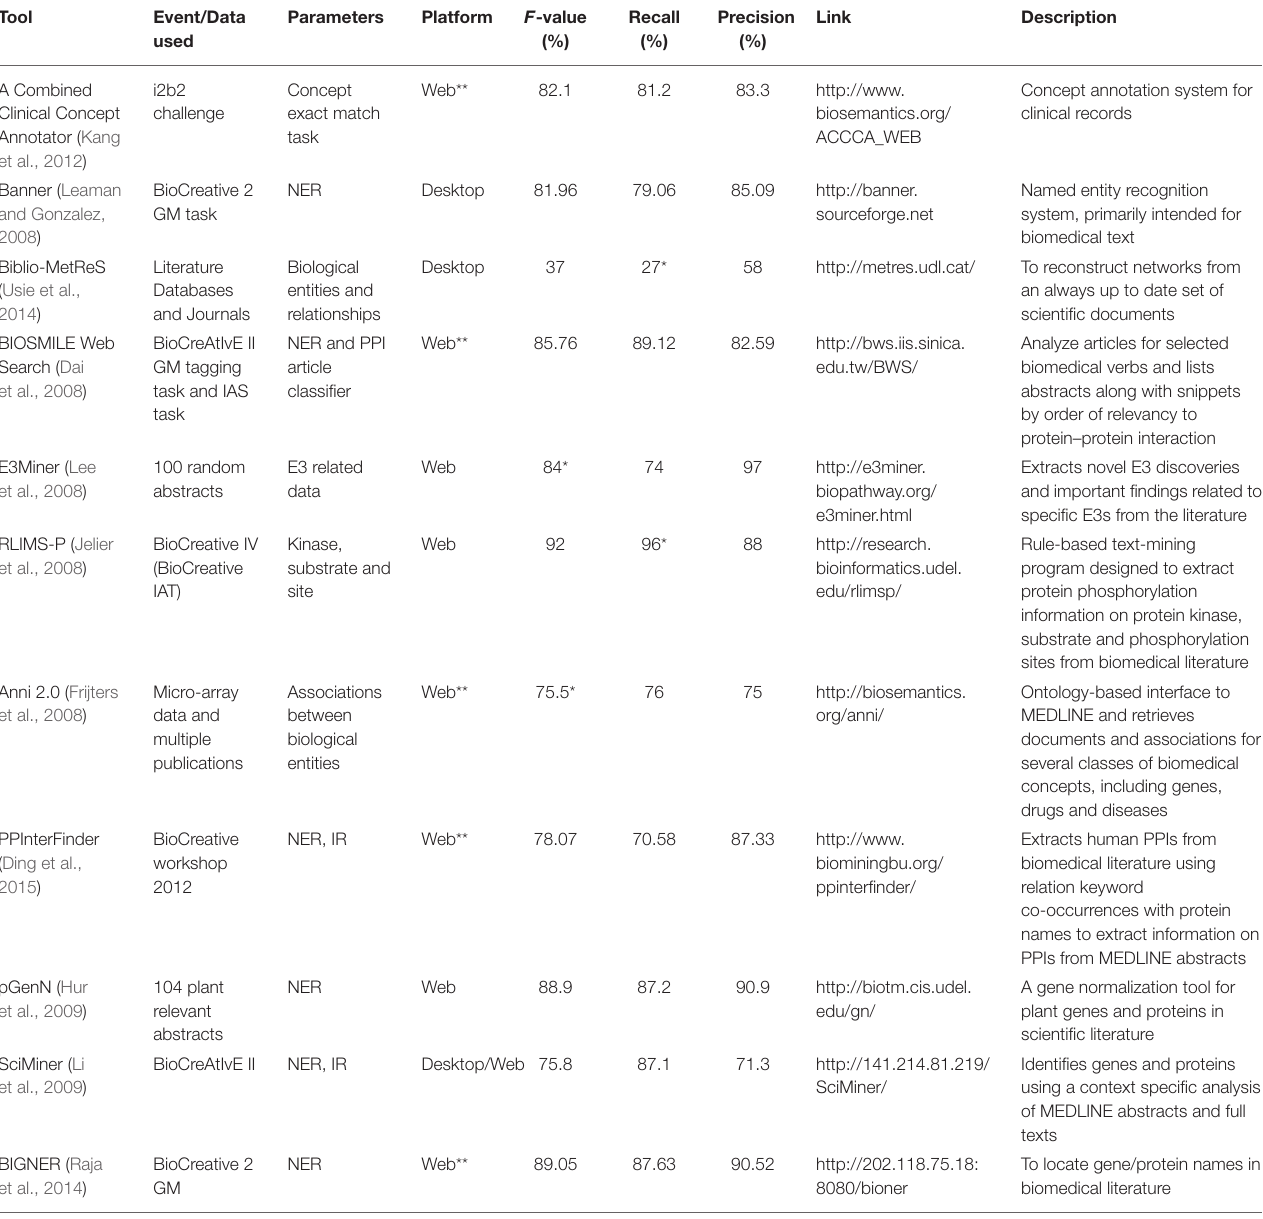
TABLE 1 | Informational (viz. data used, parameters for evaluation and working platform) and statistical (viz. f -value, recall and precision) insights for a few literature mining tools with their brief description and links to the tools’ home page.